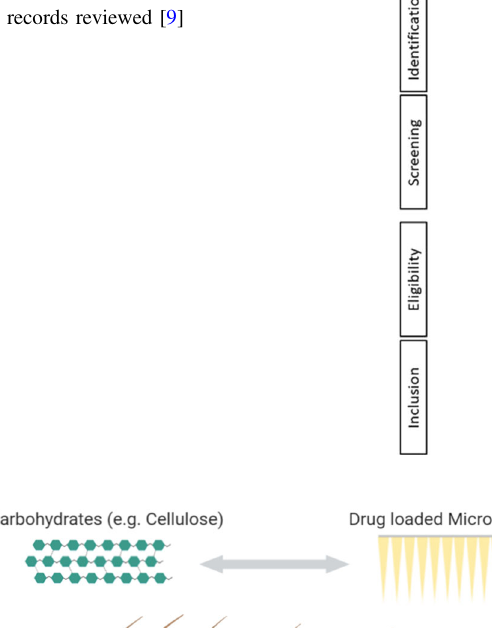
Fig. 2 PRISMA fl owchart for